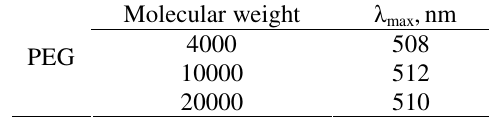
Table 2. MW and maximum absorbance wavelength of PEG Molecular